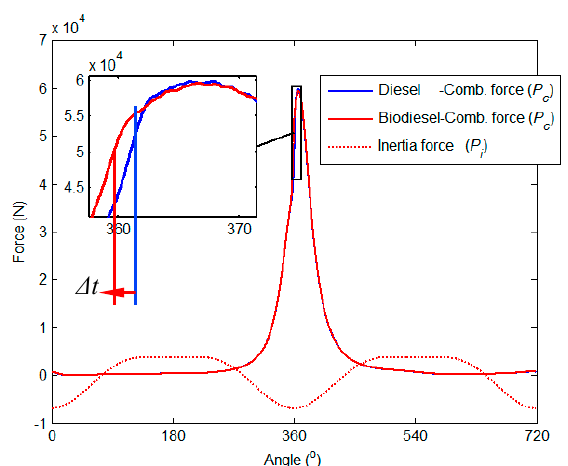
Figure 17. The decomposition of combustion force and axial inertia force.